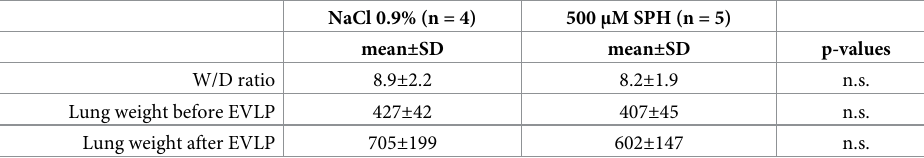
Table 3. Analysis of wet/dry ratio and total weight gain during a 3 h EVLP run.